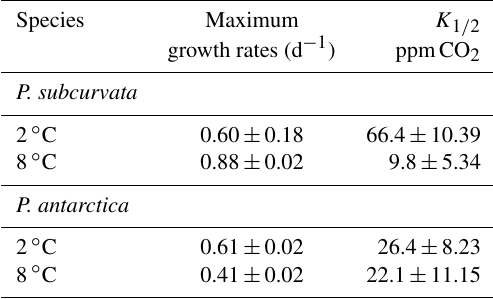
Table 4. Comparison of the curve fitting results for maximum growth rate (d − 1 ) and half-saturation constants ( K 1 / 2 ) , calculated from the CO 2 functional response curves of P. subcurvata and P. antarctica at 2 and 8 ◦ C. Values represent the means and errors are the standard errors from fitting.